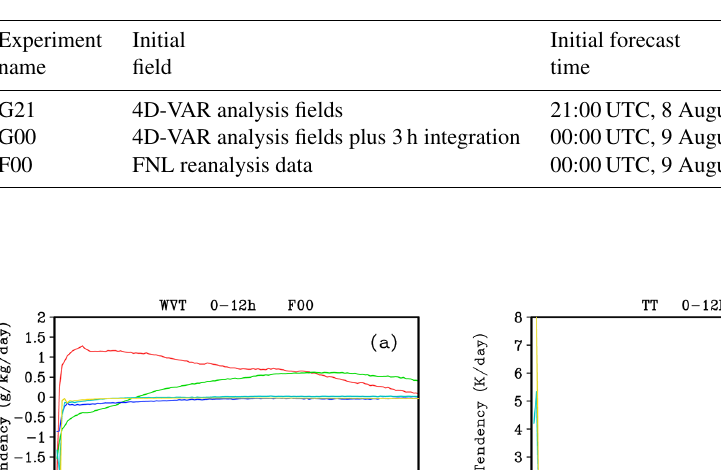
Table 1. Model setup of three experiments used in this study.